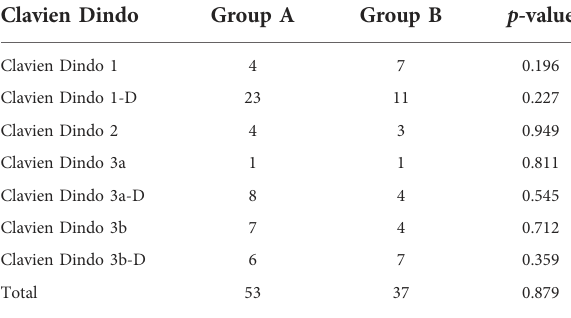
TABLE 3 Statistical comparison between complication sub-groups. 0.05 was considered for statistical signi fi cance.